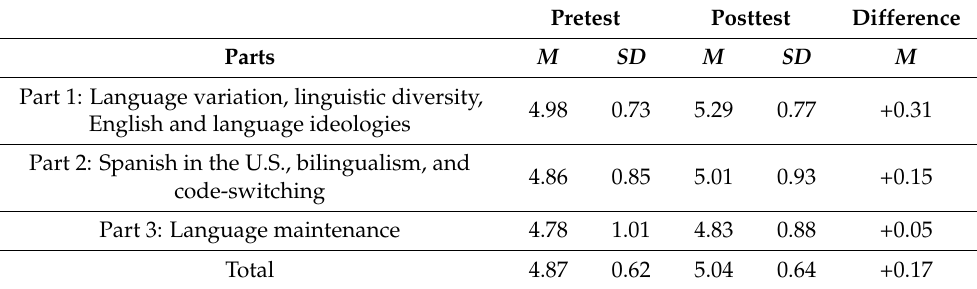
Table 2. Critical Language Awareness Questionnaire Results ( N = 18).